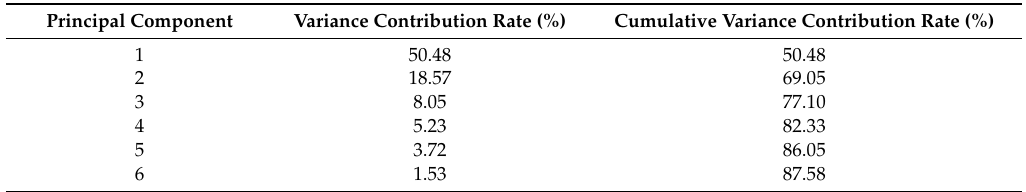
Table 2. The variance contribution rates and the cumulative variance contribution rates of six principle